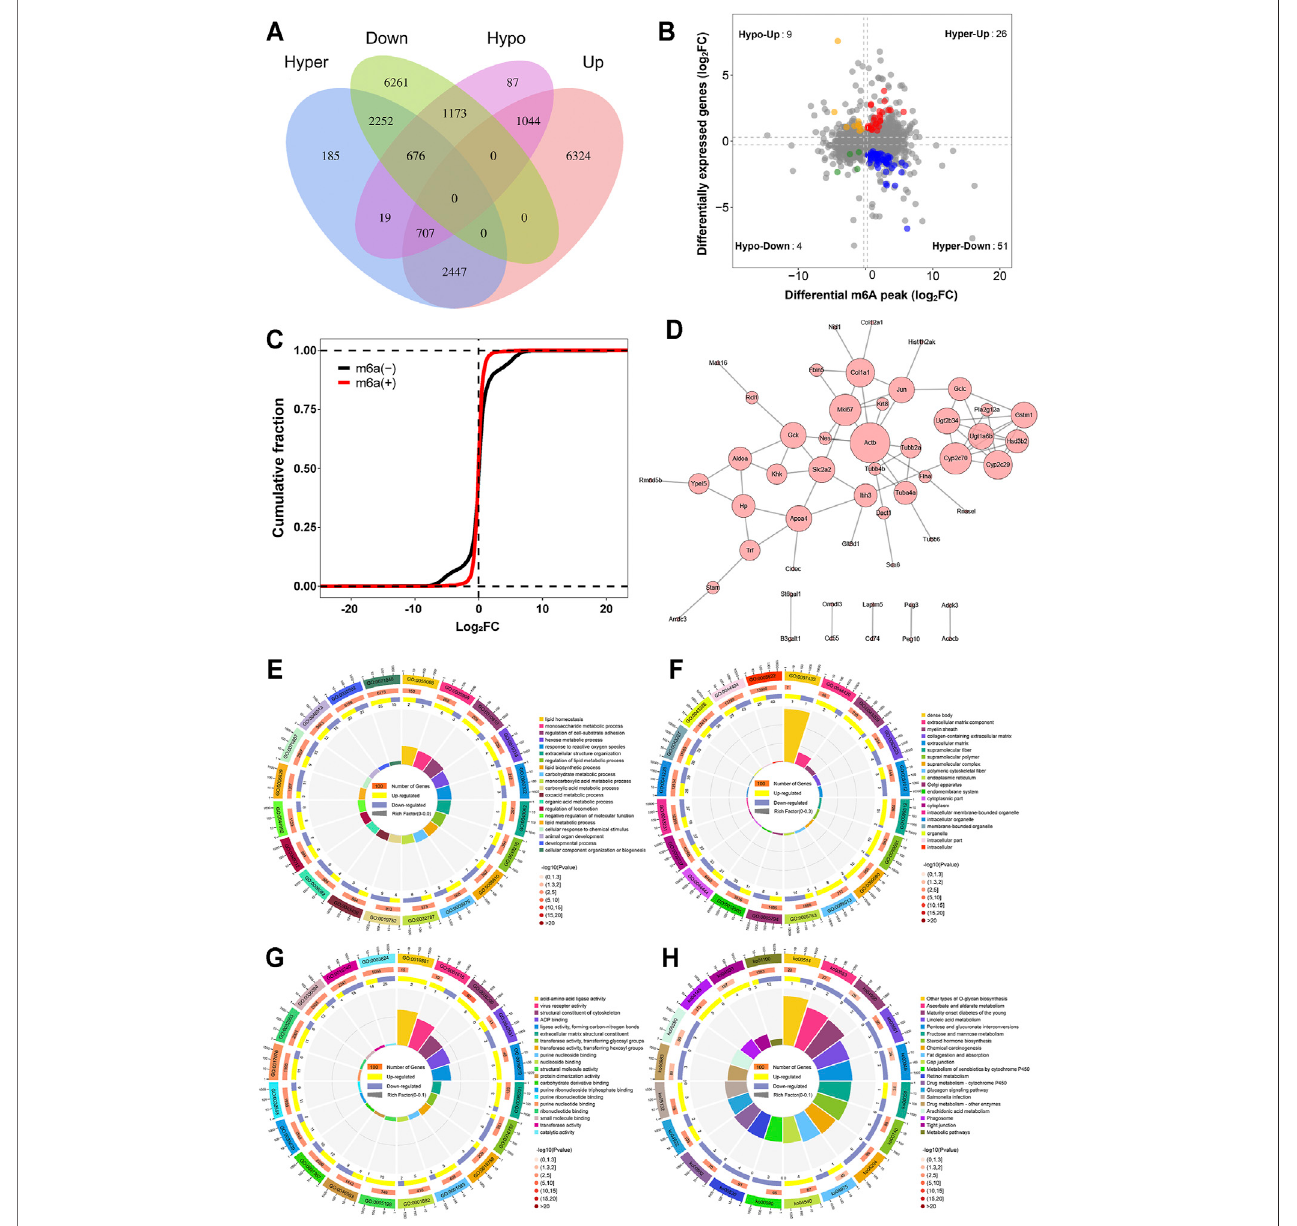
FIGURE 6 | Joint analysis of m6A methylation and mRNA expression. (A) Venn diagram of peaks with m6A methylation and mRNA. (B) Four quadrant graph of geneswithdifferentialm6AmethylationanddifferentiallyexpressedmRNAlevels. (C) Cumulativefrequencyplotshowingthattherewasacorrelationbetweendifferential m6A methylation genes and mRNA levels. (D) PPI of genes with differentially expressed m6A methylation and differentially expressed mRNA. (E) GO biological processes enrichment analysis. (F) GO cellular component enrichment analysis. (G) GO molecular function enrichment analysis. (H) KEGG enrichment analysis.